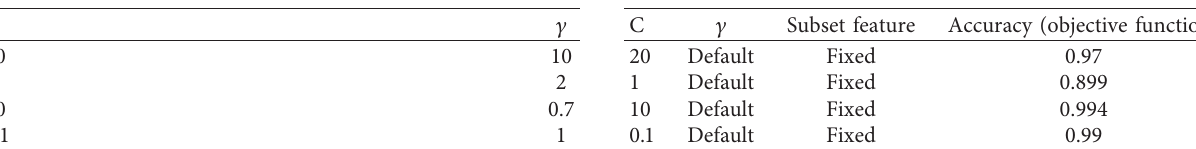
Table 5: Accuracy based on c